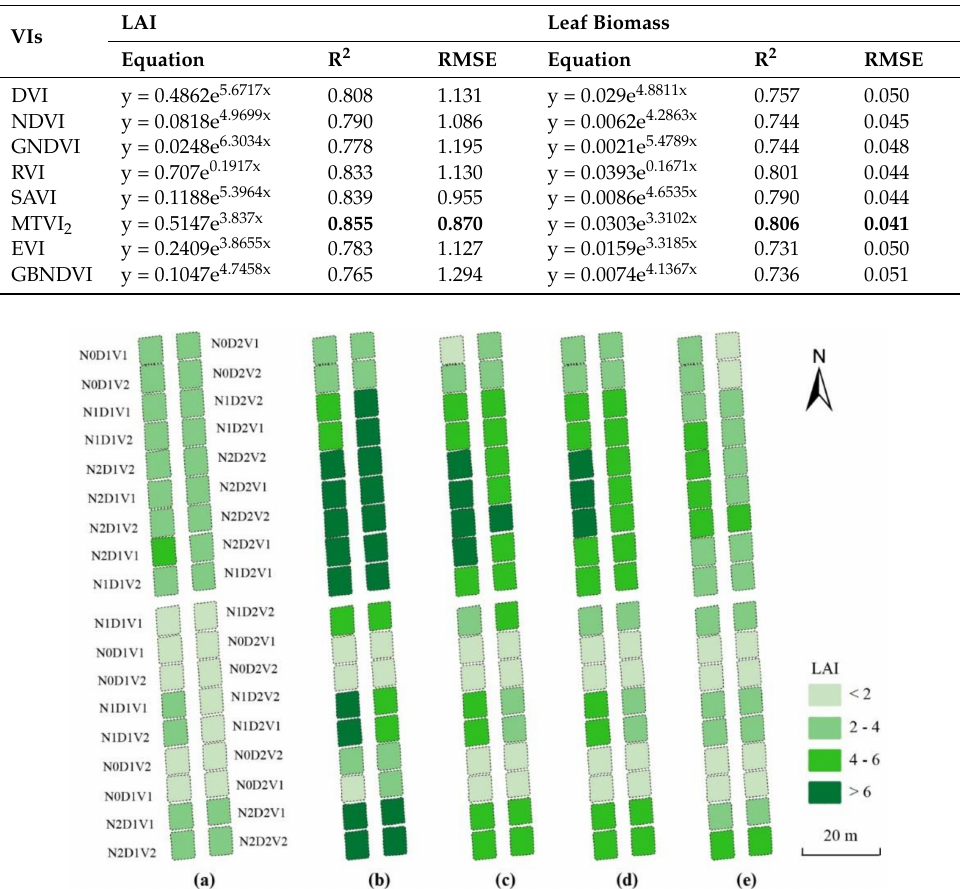
Figure 12. Leaf area index (LAI) mappings using the relationship between MTVI 2 and LAI at different growth stages: ( a ) jointing stage; ( b ) booting stage; ( c ) heading stage; ( d ) anthesis stage; and ( e ) filling stage. N is nitrogen rate (N0 = 0, N1 = 150, N2 = 300 kg/ha). D is row spacing (D1 = 25, D2 = 40 cm). V represents the wheat varieties Shengxuan 6 (V1) and Yangmai 18